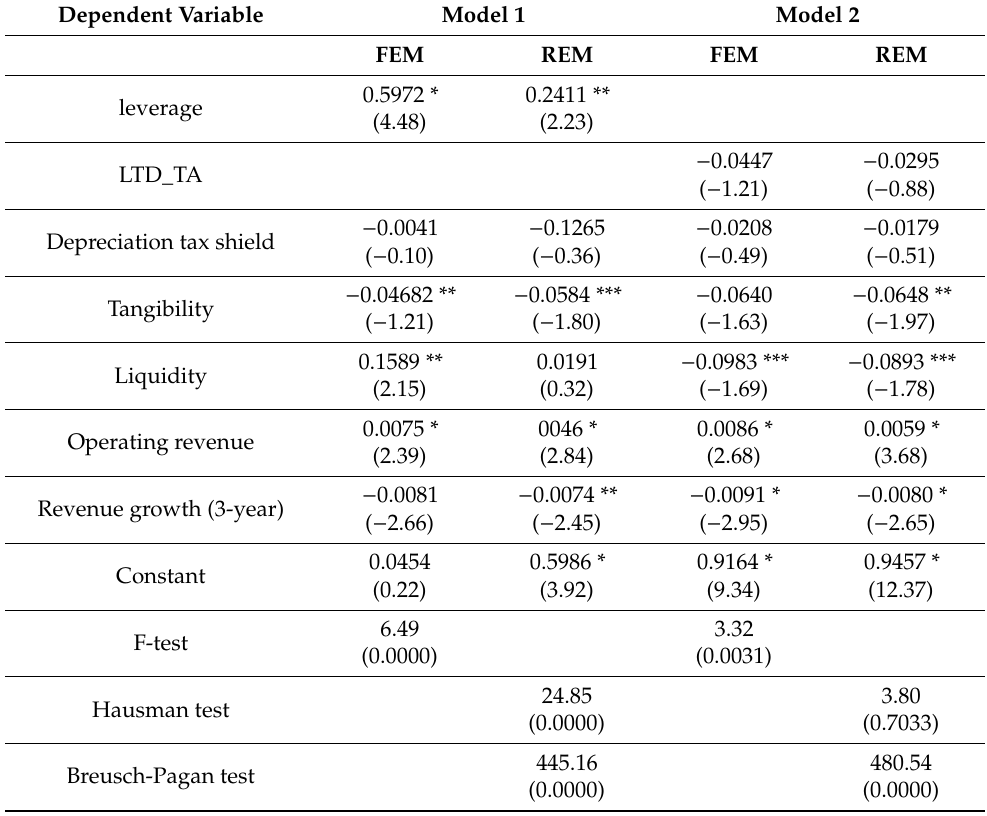
Table 4. Panel regression outputs for operating margin (dependent